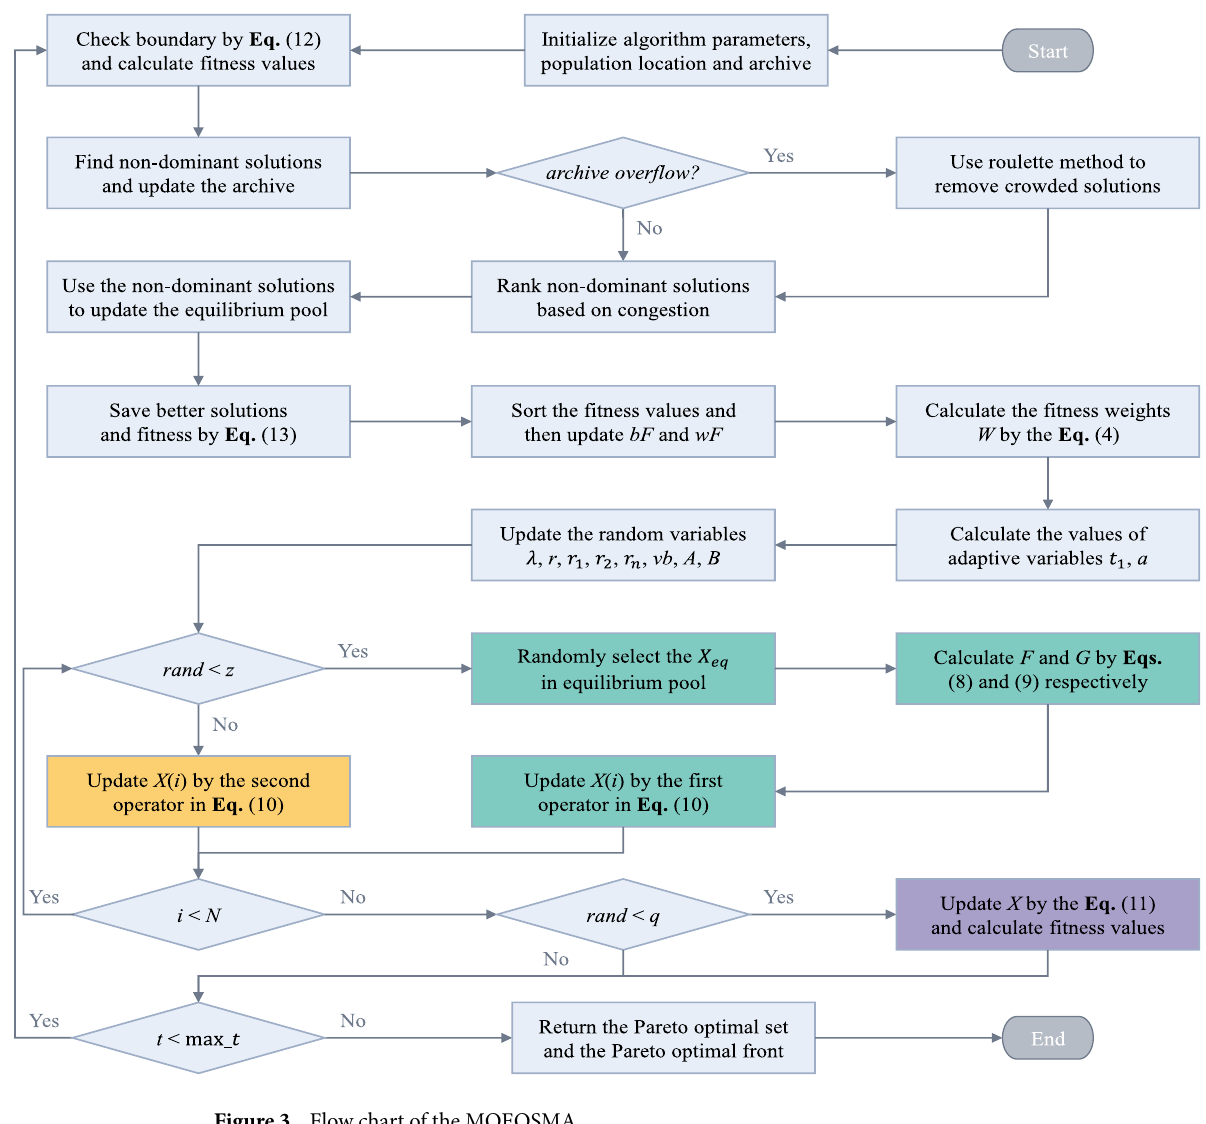
Figure 3. Flow chart of the